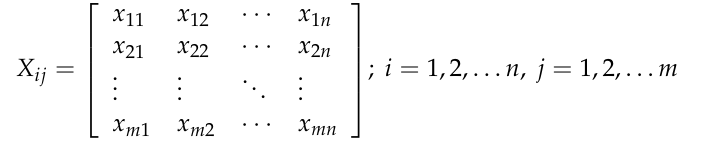
Table 3. Linguistic scale and their associated TFNs. Linguistic Scale Crisp Value Very Low (VL) 1 Low (L) 2 Medium (M) 3 High (H) 4 Very High (VH)